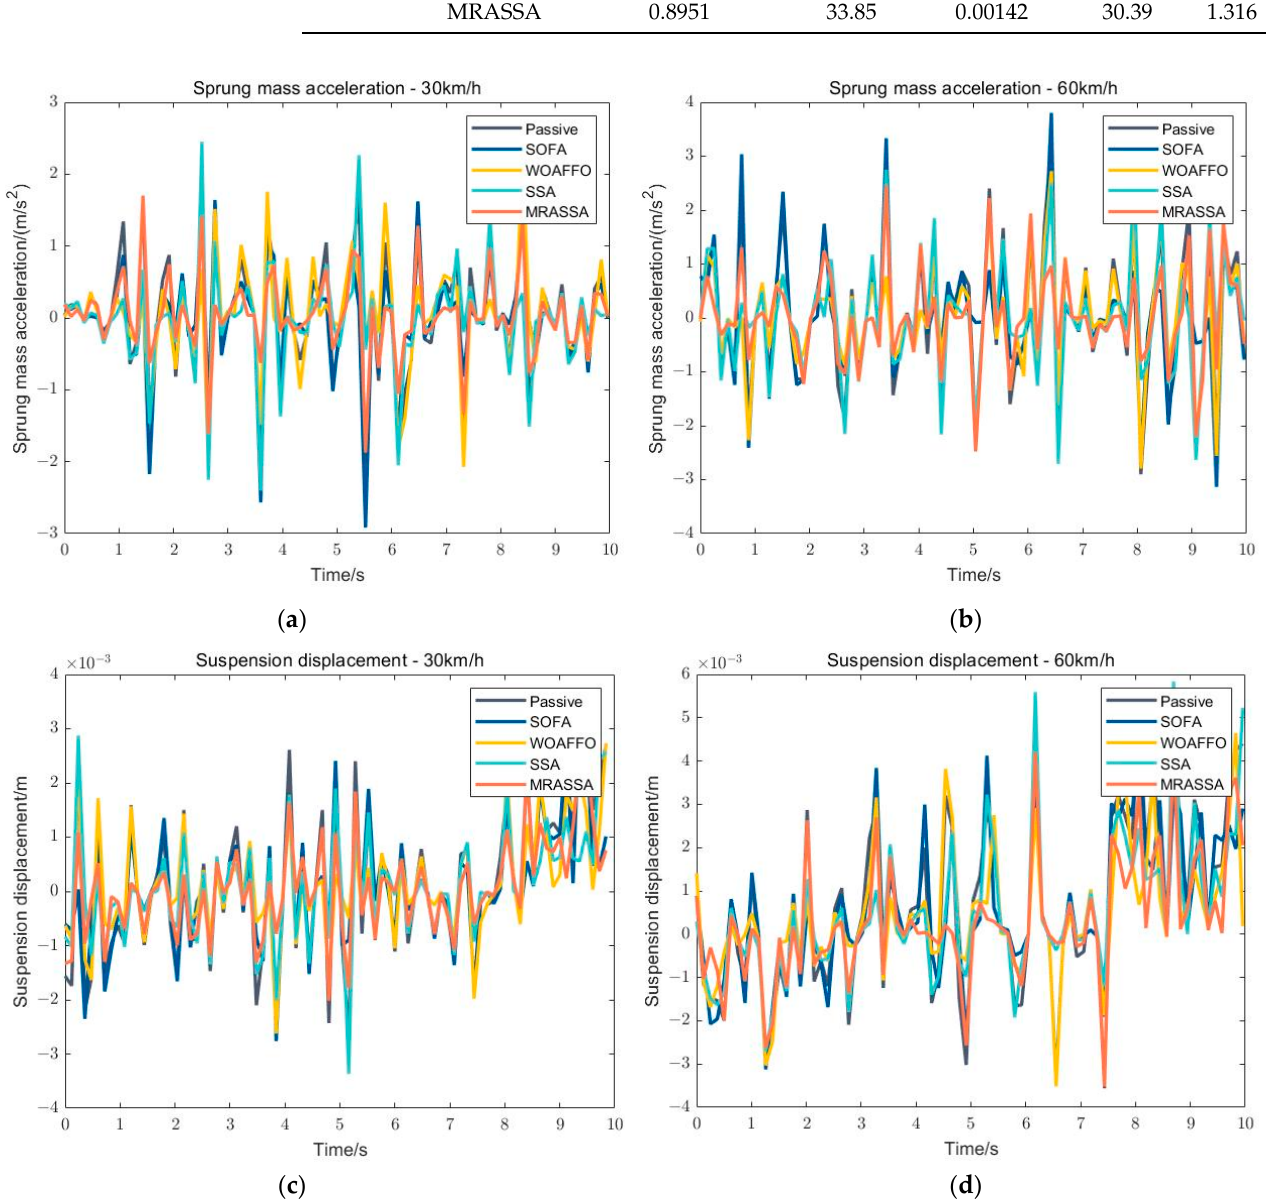
Figure 12. Suspension performance at the random road in the experimental platform. ( a ) Suspension acceleration at 30 km/h; ( b ) Suspension acceleration at 60 km/h; ( c ) Suspension displacement at 30 km/h; ( d ) Suspension displacement at 60